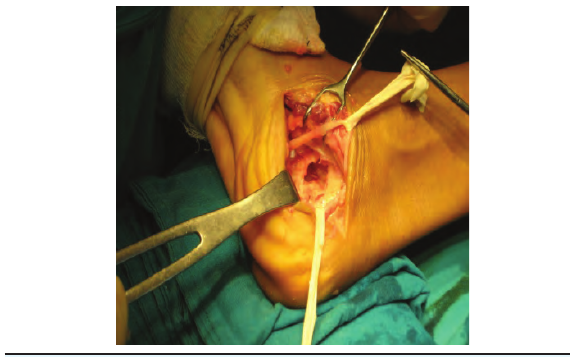
Figure 3. intraoperative picture showing erosion of the calcaneum.